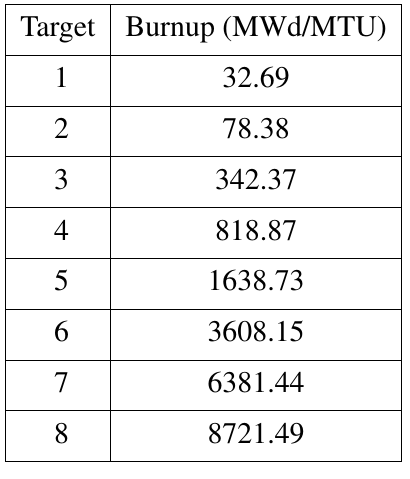
Table 2: Burnup Targets for Fuel Burn Correction